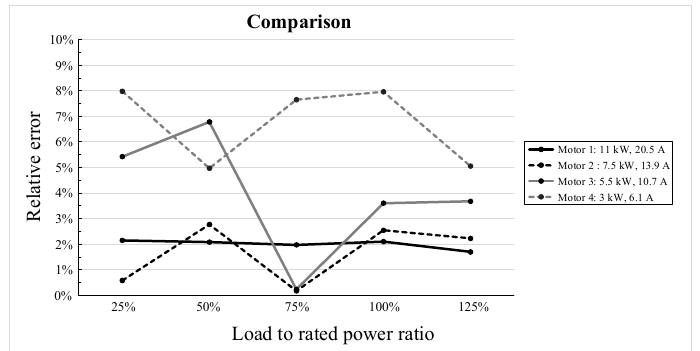
Figure 12. The relative error vs. load to rated power ratio for the four considered three-phase induction motors.